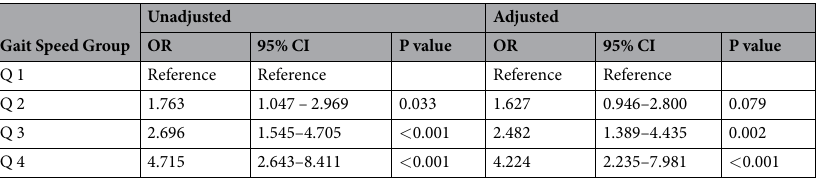
Table 3. Multivariate logistic regression for independent associations between gait speed quartiles and higher complexity of care needs. Adjusting for age, education, BMI, CCI, Dynapenia. CCI: Charlson’s comorbidity index; BMI: body mass index; RAP: Resident assessment protocol. Dynapenia: Based on Handgrip strength < 26 kg. Higher complexity of care needs: defined as ≥ 4 RAP triggers. Q 1: gait speed > 1.000. Q 2: gait speed